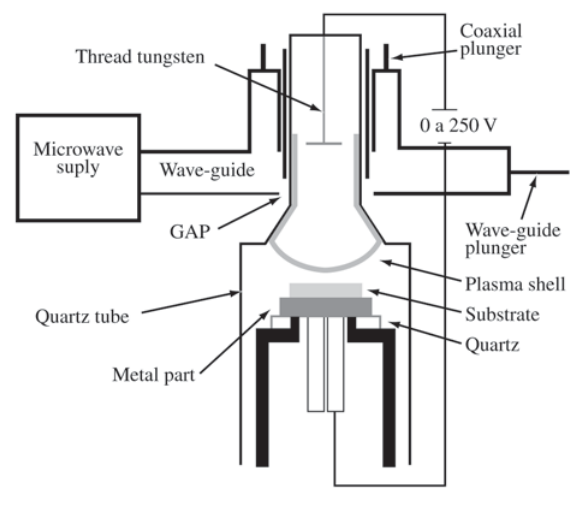
Figure 1. Schematic diagram for BEN inside quartz tube in the Surfatron